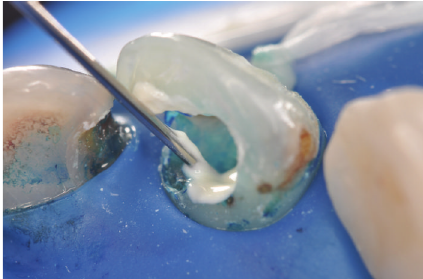
Figure 11: Root canal filling using calcium hydroxide Calen (SSWhite Duflex, Rio de Janeiro, RJ, Brazil).